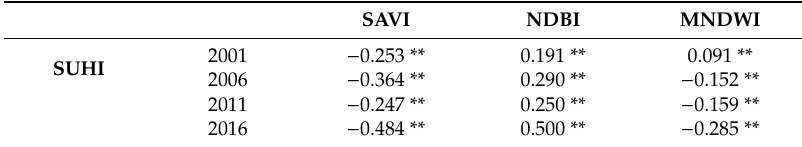
Table 2. Pearson’s r between the SUHI and biophysical